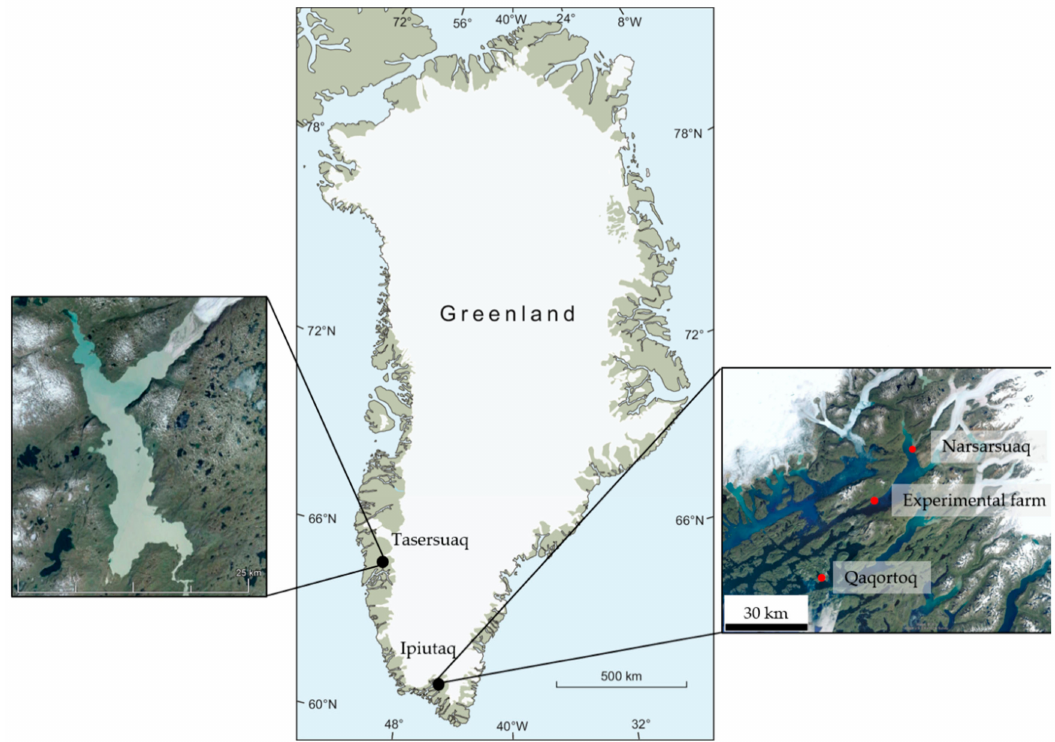
Figure 1. Overview of the two study areas. Tasersuaq is the lake in which the glacial rock flour was sampled. Ipiutaq is the experimental site, where the glacial rock flour was used as a soil amendment. The map of Greenland is constructed in ArcMap, while the two insets are from Google